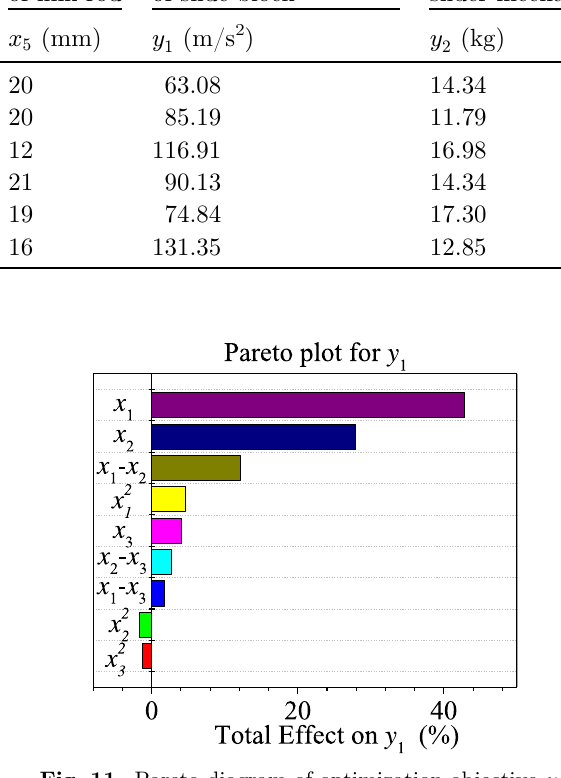
Fig. 11. Pareto diagram of optimization objective y 1 .